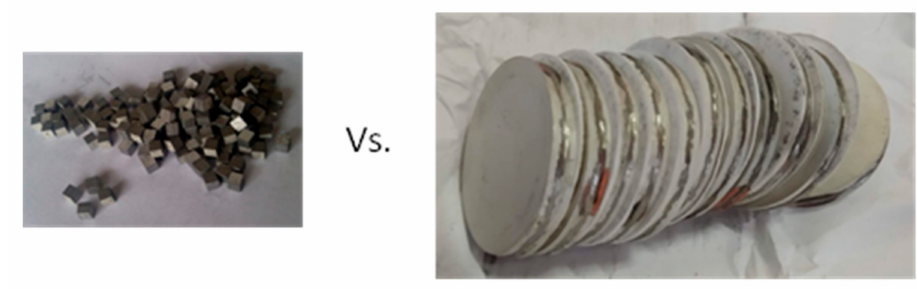
Figure 2. Example of small vs. large TE element, with 24 mm diameter BiTe elements.